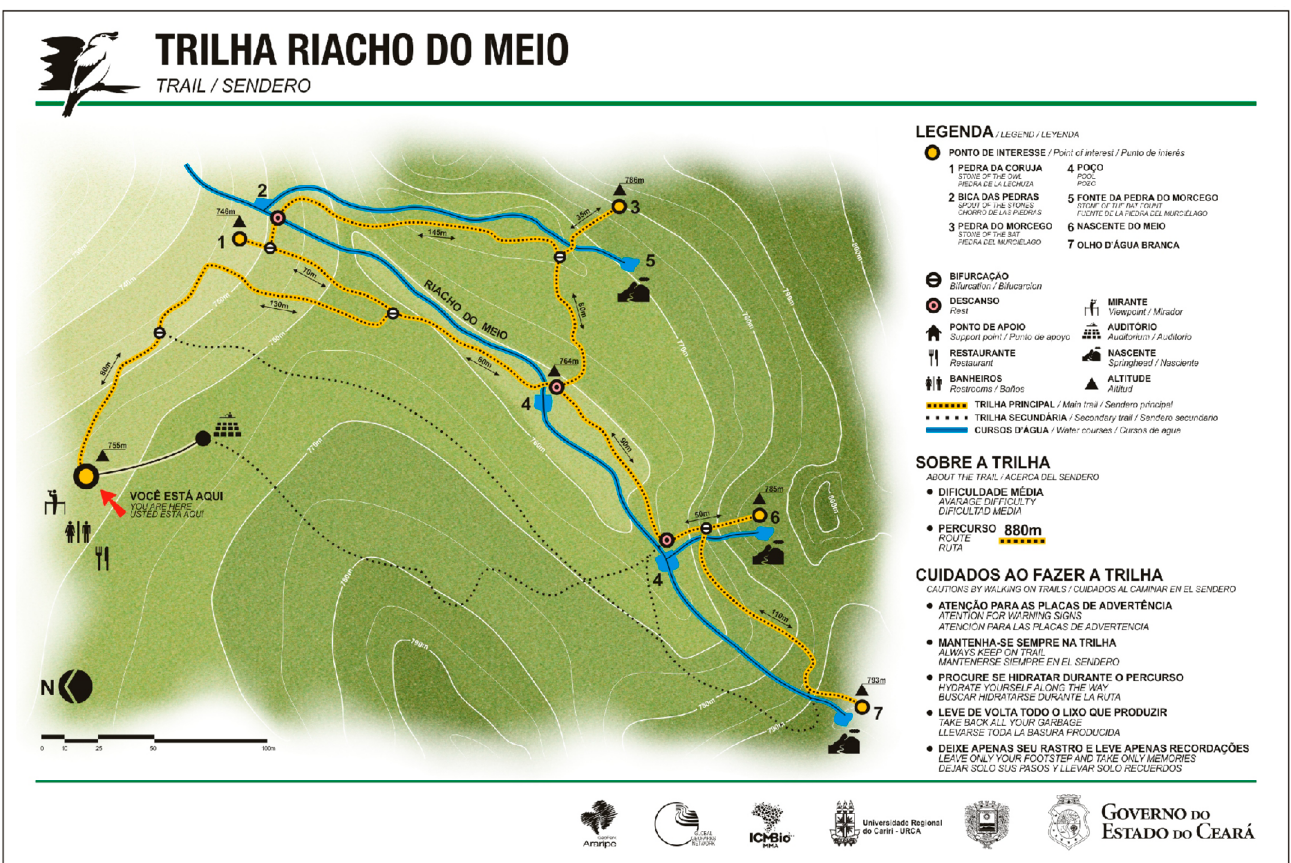
Figure 2. Riacho do Meio Trail in the homonymous Geosite. Source: Trail Signaling Plan Araripe UGG [52].